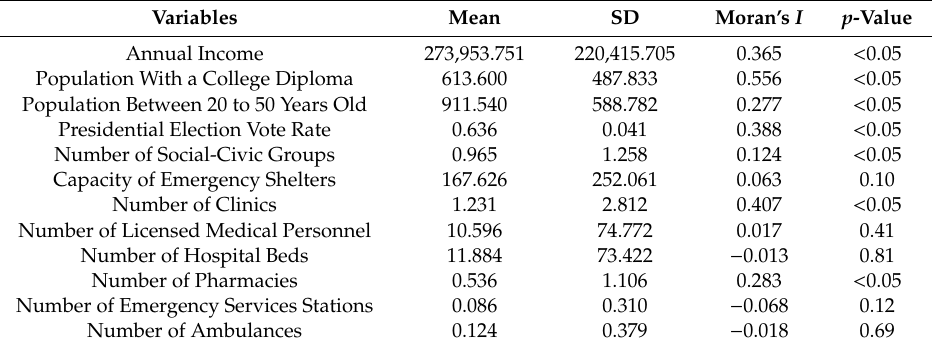
Table 1. Variables and descriptive statistics.